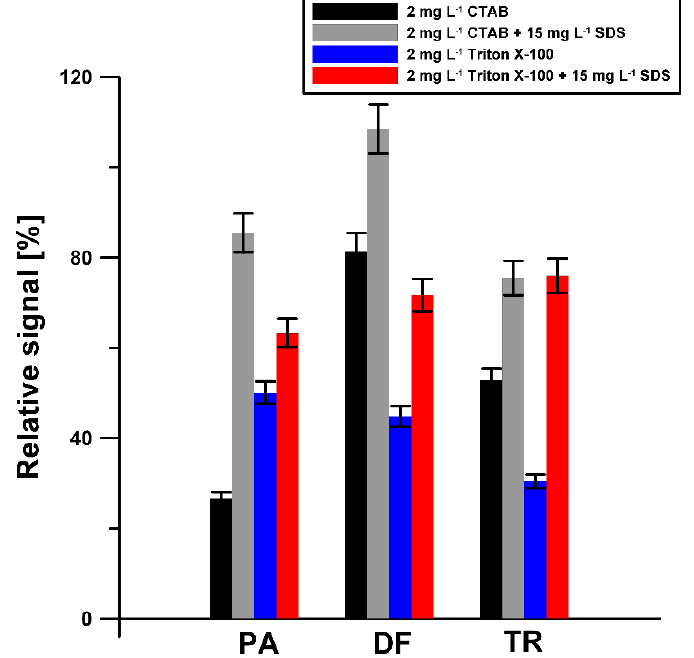
Figure 8. Influence of 2 ppm Triton X-100 and CTAB on voltammetric response of 5 × 10 −6 mol L −1 PA, 2 × 10 −7 mol L −1 DF, and 2 × 10 −6 mol L −1 TR in the absence and presence of 15 mg L −1 SDS.